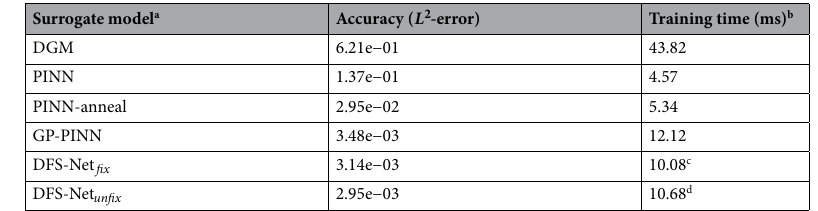
Table 2. Comparison of the relative L 2 -error of different neural network-based surrogate models on the Helmholtz equation ( α 1 = 2, α 2 = 3 ). a All models consists of three hidden layers with 50 neurons in each layer. b The training time for each Adam epoch. c The training time of DFS-Net fix for each L-BFGS-B epoch is 22.00 ms. d The training time of DFS-Net unfix for each L-BFGS-B epoch is 23.86 ms.